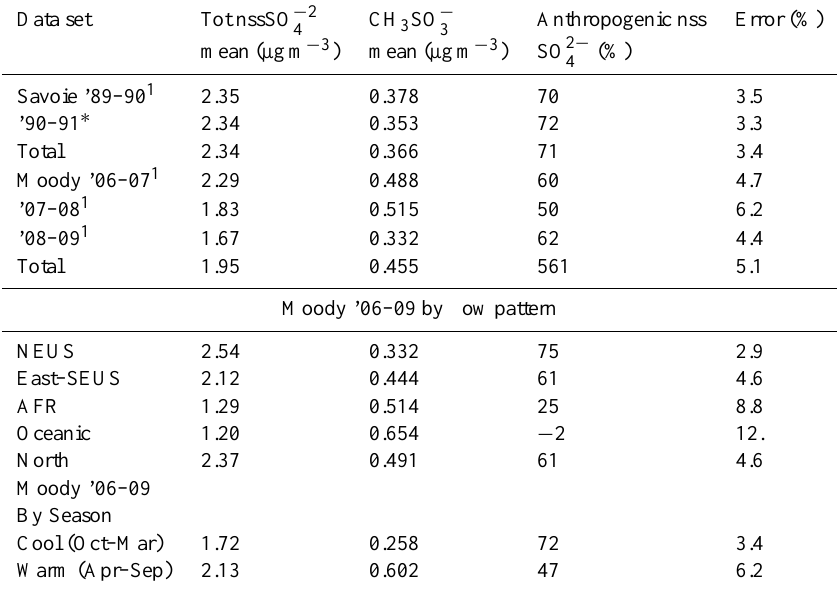
Table 5. Mean nss SO − 2 and CH 3 SO − concentrations for Bermuda data from 1989 to 1990 (Savoie et al., 2002) and current Bermuda 4 3 data from 2006 to 2009, with estimates of the the percentage contribution of anthropogenic (and % error), based on the